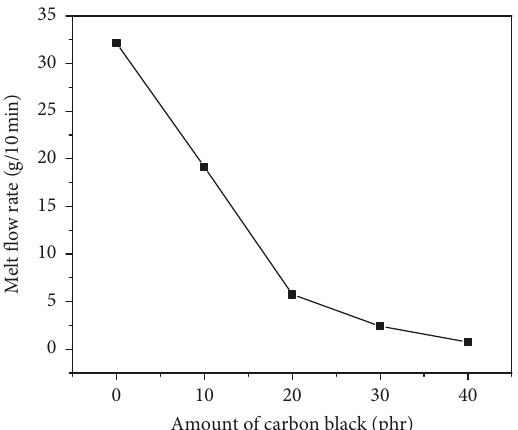
Figure 1: Melting flow rate of pristine PBS and x CB-PBS composites ( x � percentages of CB additive with respect to the amount of PBS matrix). Note that the solid line is only used as a guide to the